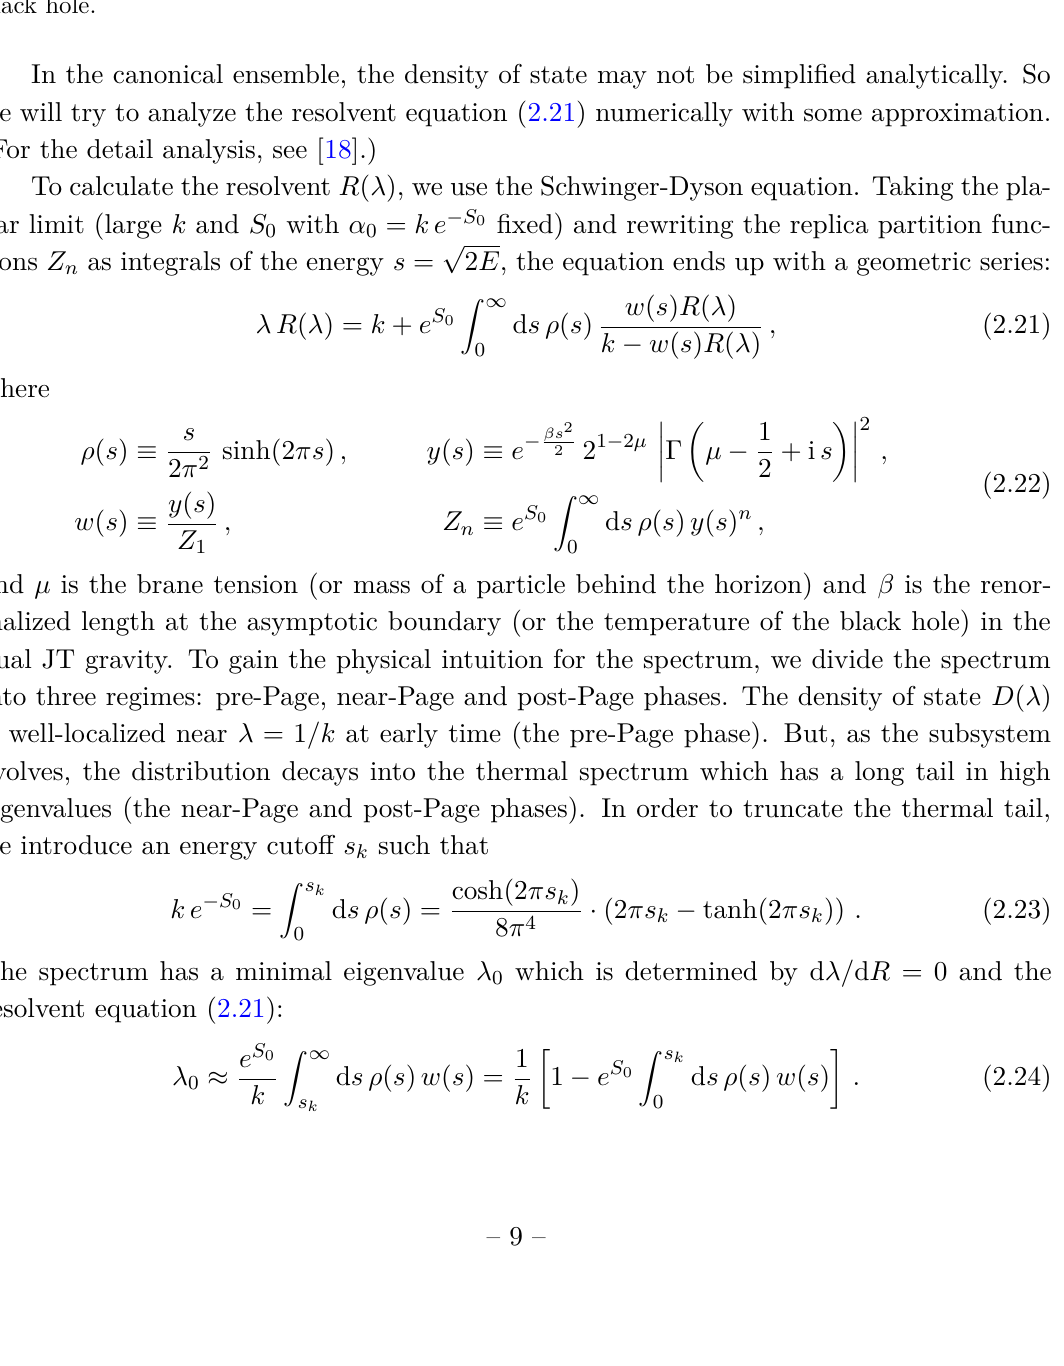
Figure 3 . The entanglement entropy S R (2.18) [Left] and capacity of entanglement C R (2.19) [Right] for the EOW brane model with S = 2 in the microcanonical ensemble. The capacity has a peak at the Page time log k = S , which clearly shows the crossover from the fully disconnected to fully connected replica wormhole solutions describing the Hawking radiation in an evaporating black